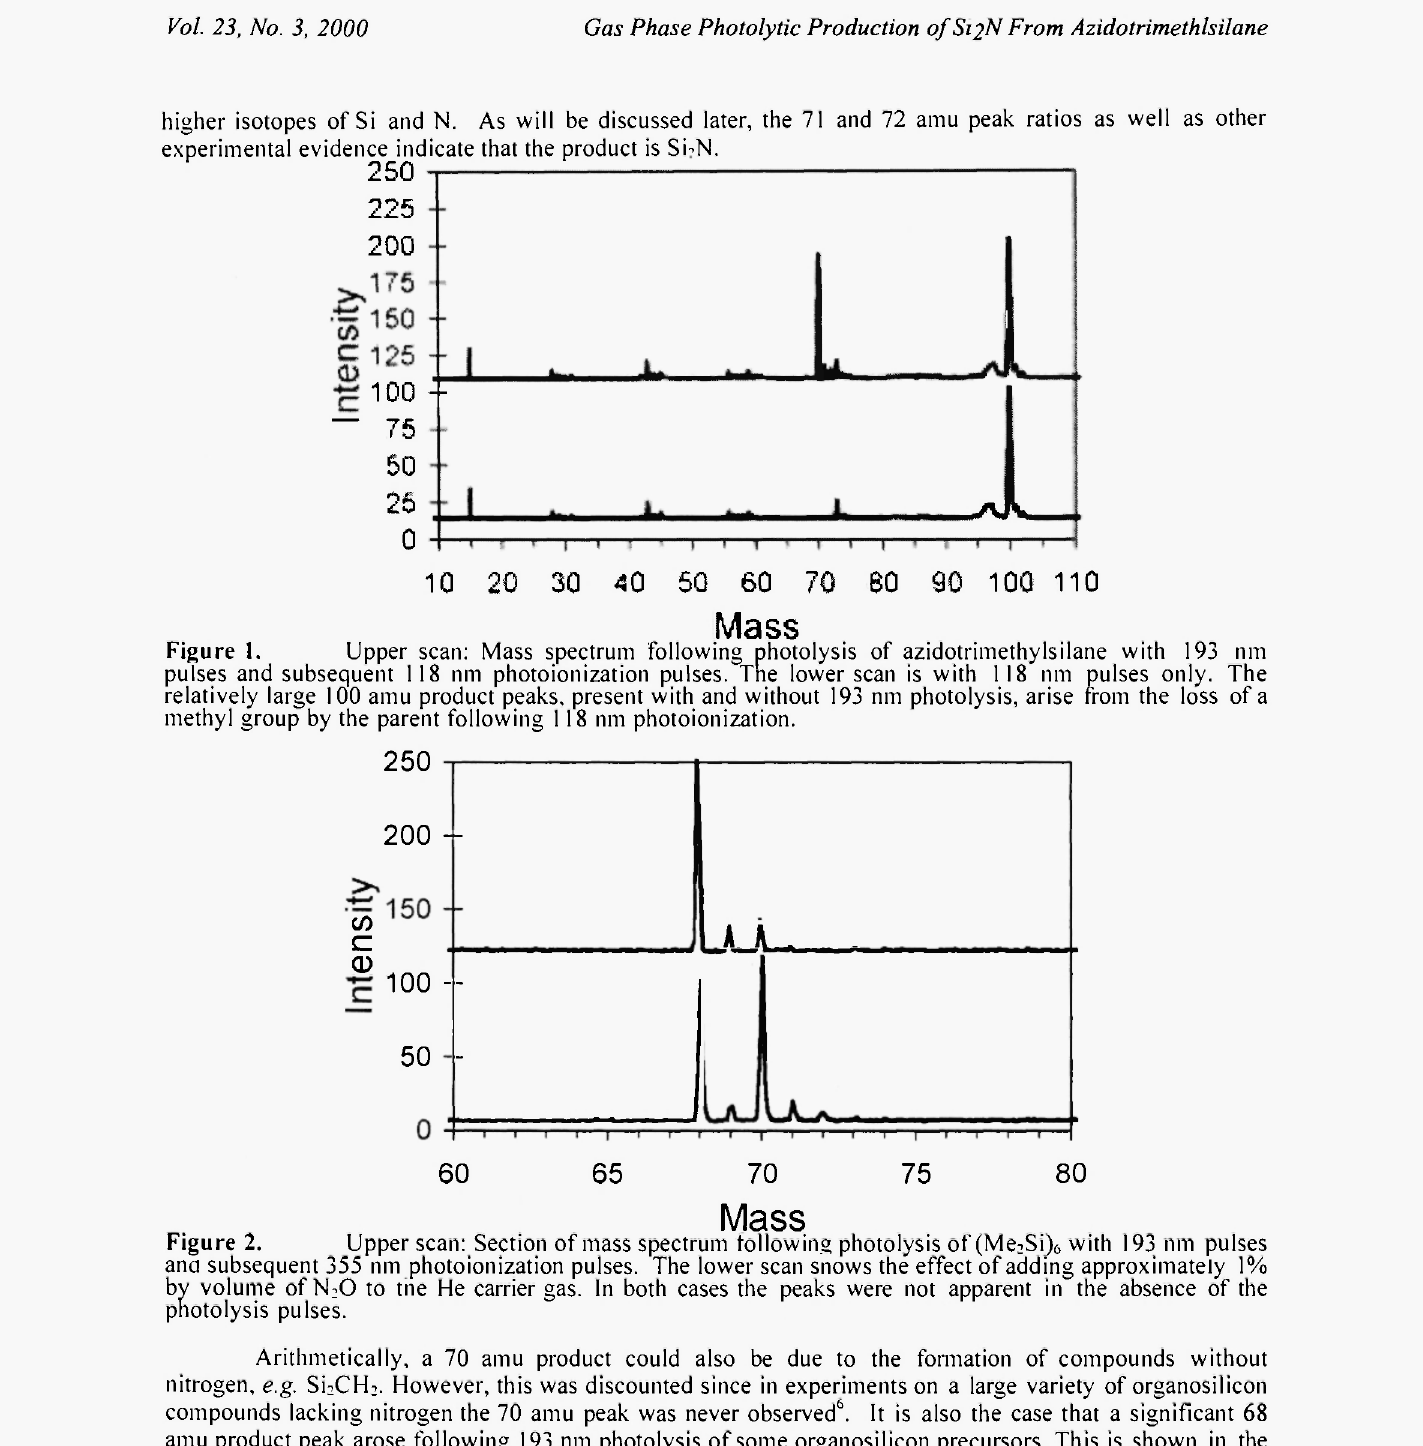
Upper scan: Section of mass spectrum following photolysis ot (Me 2 Si) 6 with 1 93 nm pulses ana subsequent 355 nm photoionization pulses. The lower scan snows the effect of adding approximately